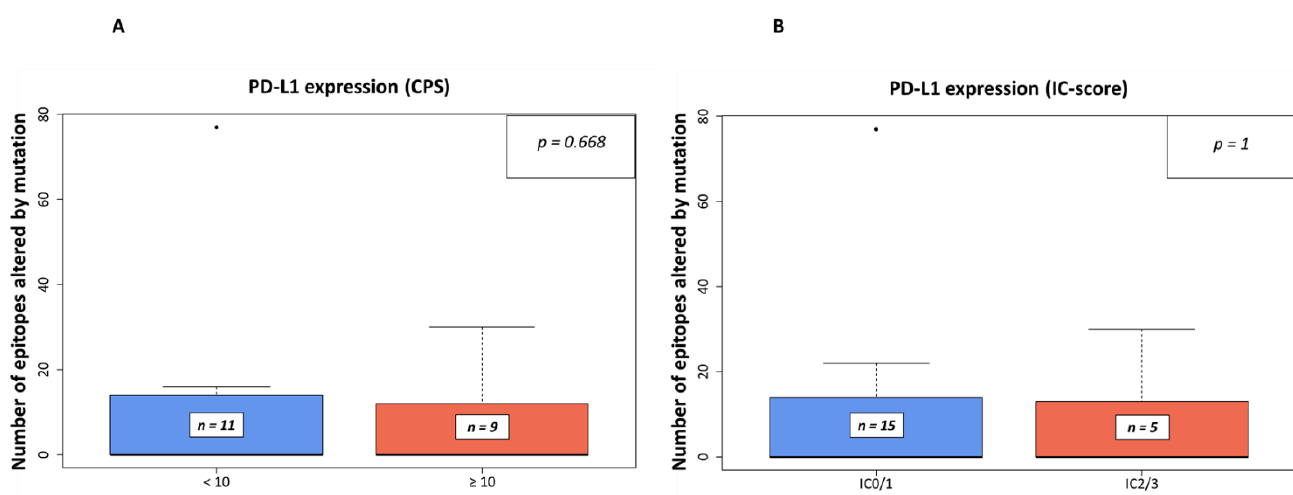
Figure 2. Number of epitopes altered by mutation in relation to PD-L1 expression in IHC-analyses. In ( A ), the relation is shown to PD-L1 expression using the combined positive score (CPS) with a threshold of 10 as used in companion diagnostic PD-L1-IHC analyses for pembrolizumab in the first-line setting of urothelial BC, while in ( B ), the threshold was set to an IC-Score of ≥ 5% (IC0/1 vs. IC2/3) as used in the same setting for atezolizumab [21]).